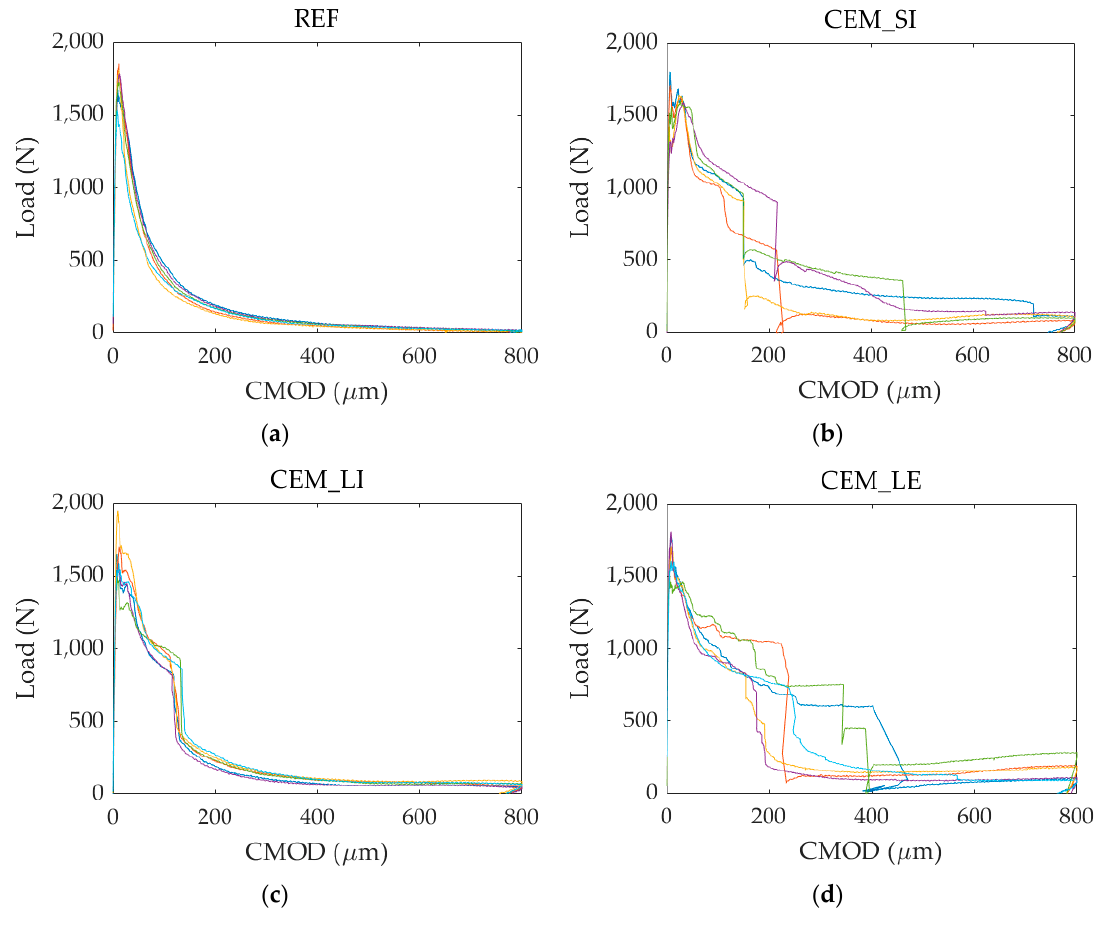
Figure 8. Load versus CMOD curves due to pre-cracking: ( a ) REF series; ( b ) CEM_SI series; ( c ) CEM_LI series; ( d ) CEM_LE series. The specimens are distinguished by di ff erent colour